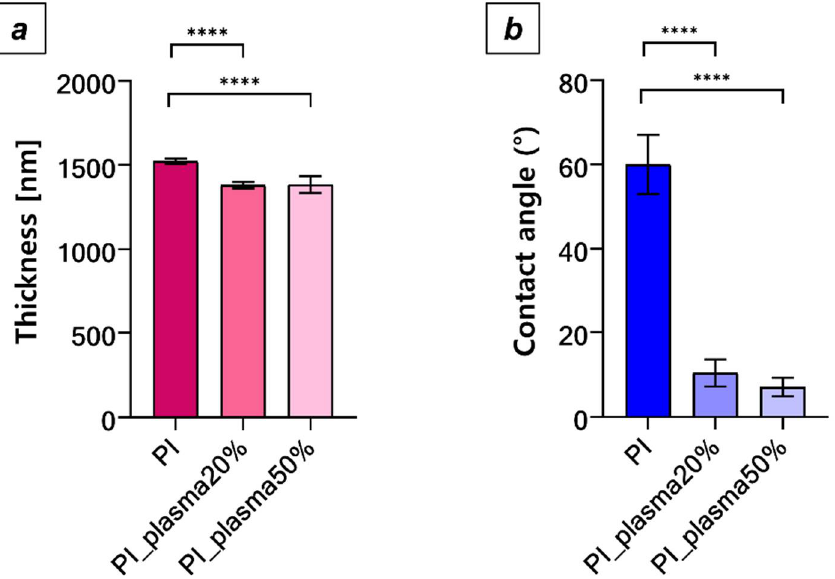
Figure 1. PI substrate characterization. ( a ) Thickness measurement of spin-coated PI samples after hard-bake procedure (PI) and after plasma treatment using different oxygen gas percentages (PI_plasma20% and PI_plasma50%). ( b ) CA measurements of untreated PI and after plasma treatment.